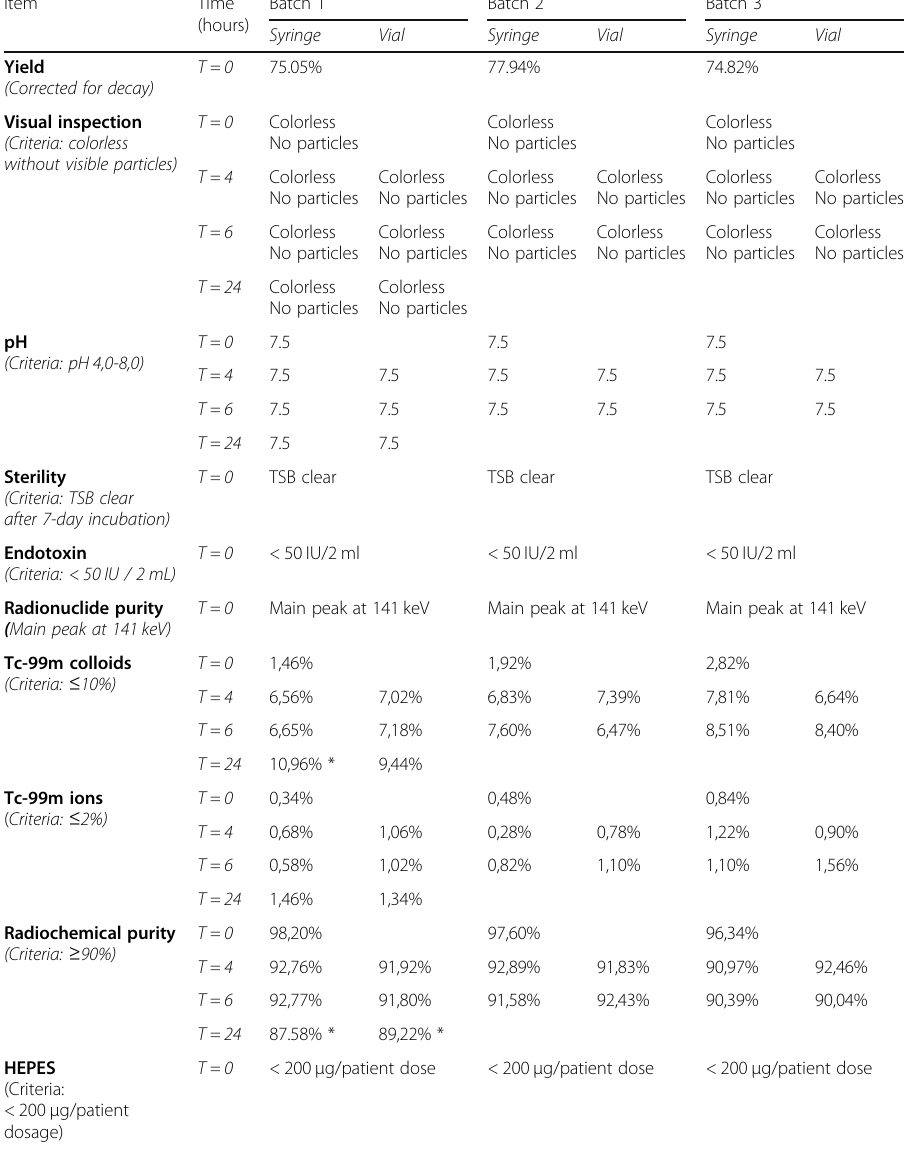
Table 1 Results of three validation batches of [ 99m Tc]Tc-PSMA Item